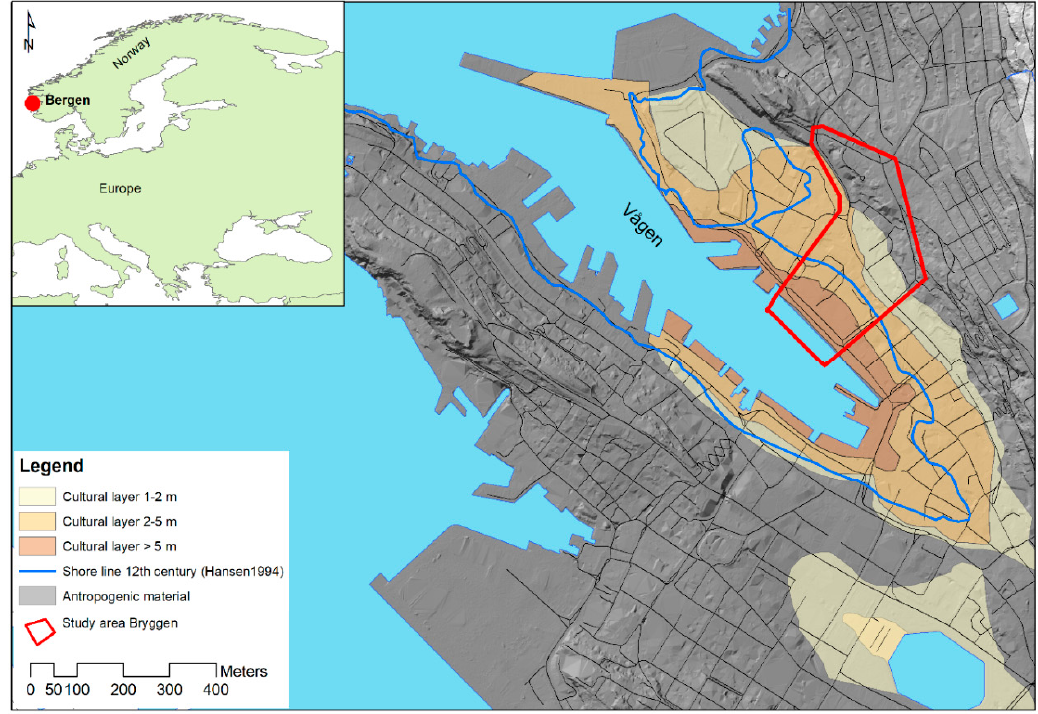
Figure 1. The Medieval city in Bergen is located along the shore of Vågen bay.